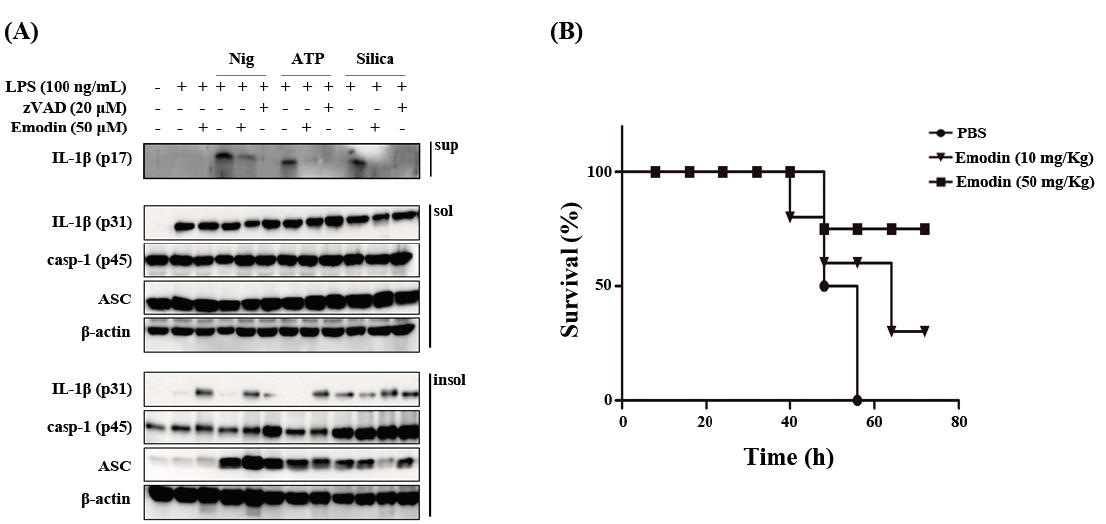
Figure 2. Effects of emodin on inflammasome component in vitro and sepsis in vivo model. ( A ) LPS-primed BMDMs were pretreated with emodin for 1 h and stimulated with nigericin (Nig) (10 μ M) and ATP (5 mM) for 1 h, and silica crystals (Silica) (150 μ g/mL) for 3 h, and supernatants were used to detect cleaved IL-1 β . Protein levels of NLRP3 inflammasome components in Triton X-100 soluble (sol) and Triton X-100 insoluble (insol) fraction lysates were used to detect internal controls, such as pro-IL-1 β (p31), ASC, pro-caspase-1 (p45), and β -actin; ( B ) Mice ( n = 5 per each group) were intraperitoneally treated with LPS (20 mg/kg) with or without emodin (10 and 50 mg/kg) and LPS (20 mg/kg). Survival rates were observed at indicated